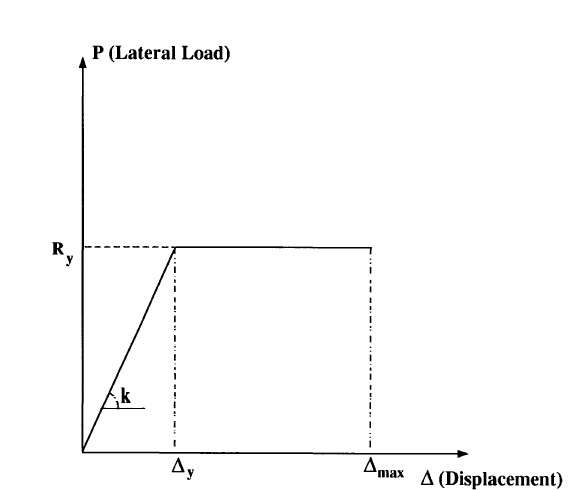
FIGURE 2 Simplified building structure behavior under lateral